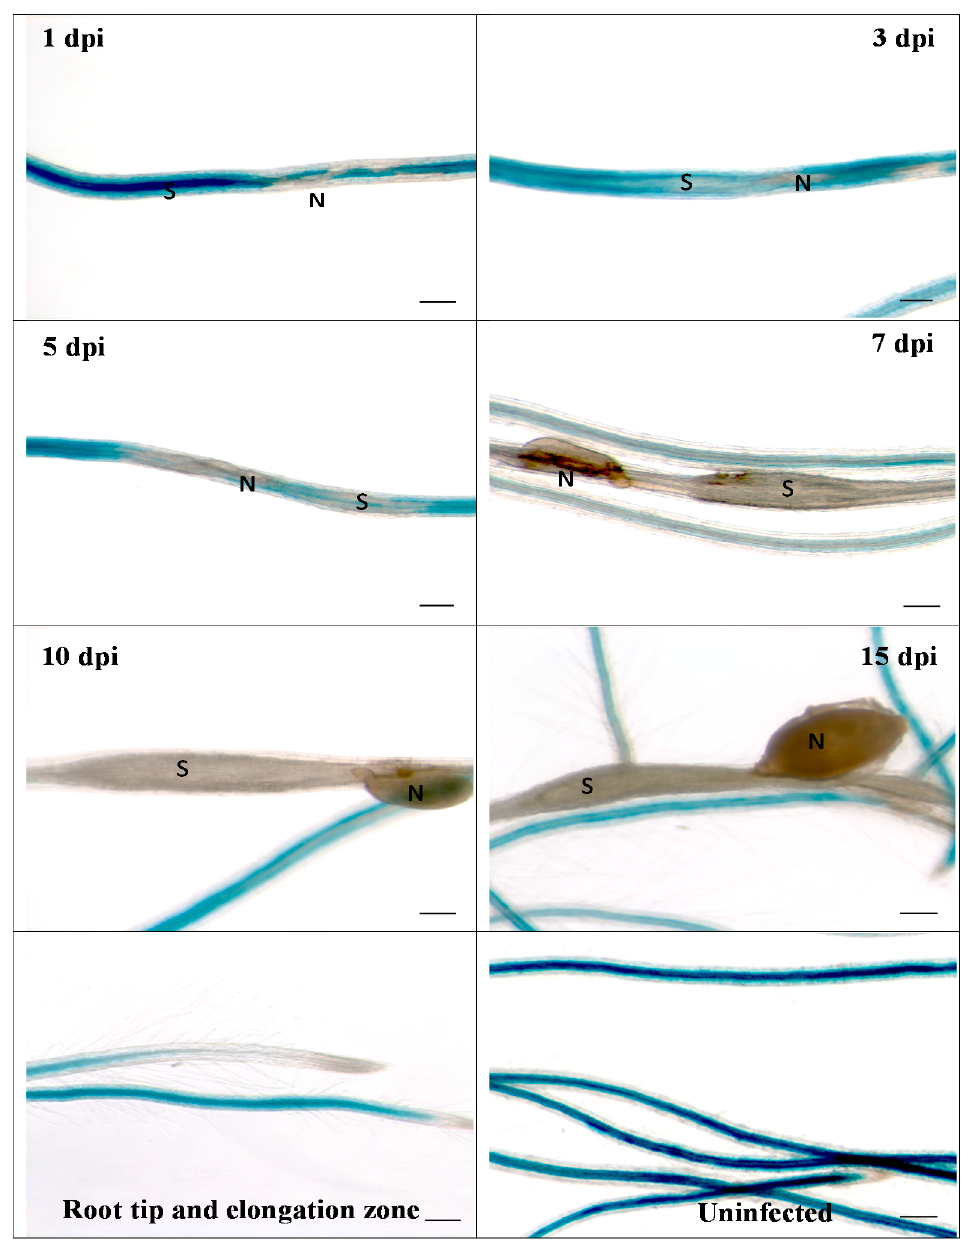
Figure 1. GUS expression in RbohB::GUS transgenic line. A – E , seedlings grown on MS medium for 3, 5, 7, 10, 15 days. GUS expression is only visible in roots, except for 15-day-old seedling shown in E . F , Enlargement of 15-day-old seedling showing GUS expression in leaf primordia. G – K , plants grown on soil in long day. G , 6-week-old plant showing GUS expression in roots. No GUS expression was found in cauline leaves ( H ), flowers ( I , J ) or siliques and seeds ( K ). Arrows in E and F point to leaf primordia.